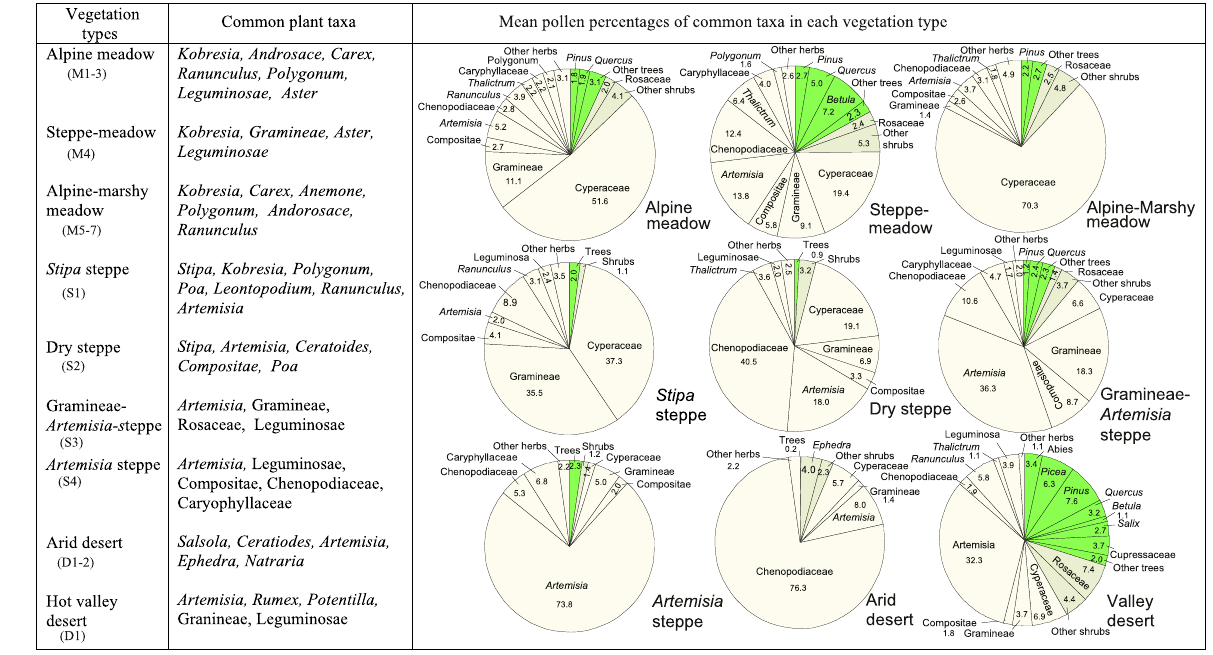
southeast (groups SM1-2) and the northeast (groups SM3, 4, 5) ( Figure 11 ). Pollen spectra from the former region contain more tree pollen than those from the latter region, re fl ecting a difference in regional vegetation. In the southeast shrub